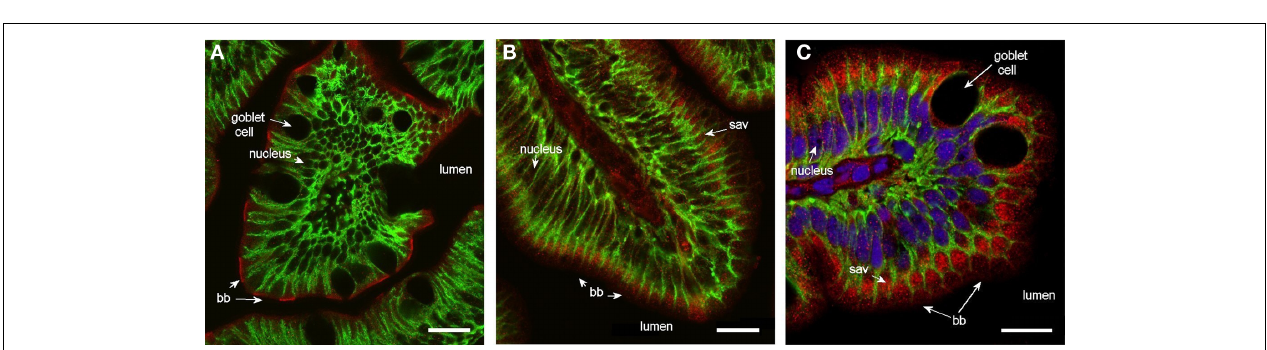
cocktail of antibodies againstAqp1aa (red) and Na + , K + -ATPase (green). Lumen, goblet cells, nuclei, and brush border (bb) are indicated. Size bar = 20 μ m.